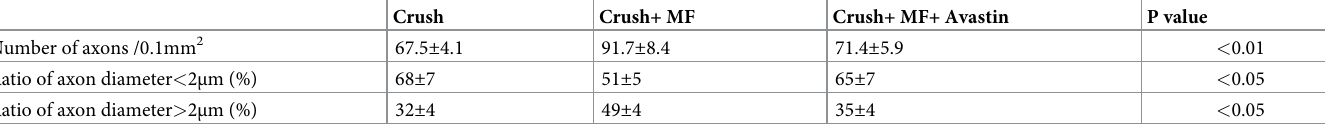
Table 5. Axon counts and diameter in various